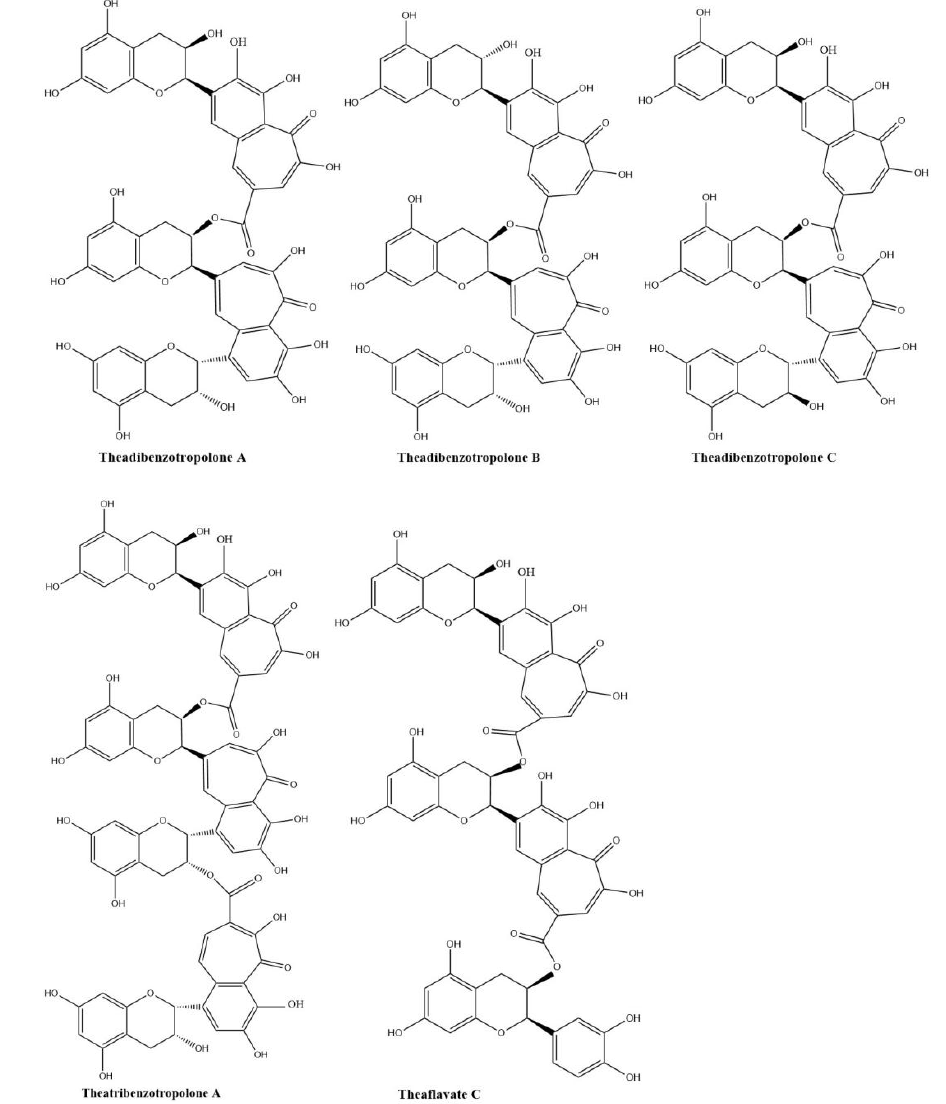
Figure 5. Structures of theadibenzotropolone A, B, and C; theatribenzotropolone A; and theaflavate C.